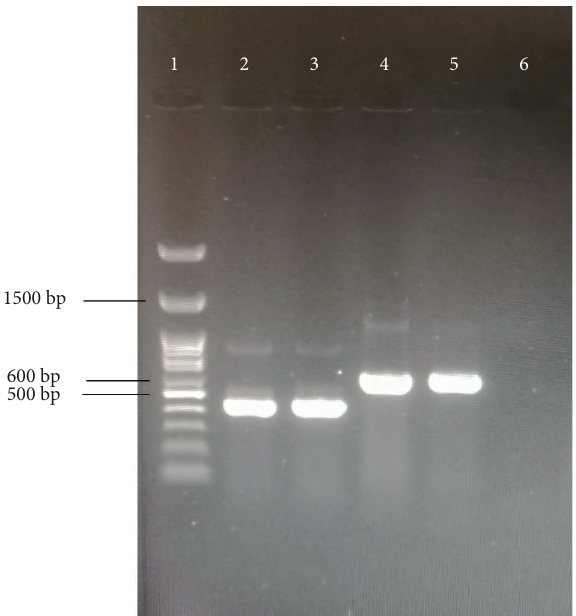
Figure 2: Colony PCR using specific PLA primers. Lane 1 is ladder 100 (bp) DNA marker, Lanes 2 and 3 are PLA (432 bp) sequence amplified using specific primers, Lanes 4 2 and 5 are amplified gene using universal M13 primers (580 bp), and Lane 6 is negative